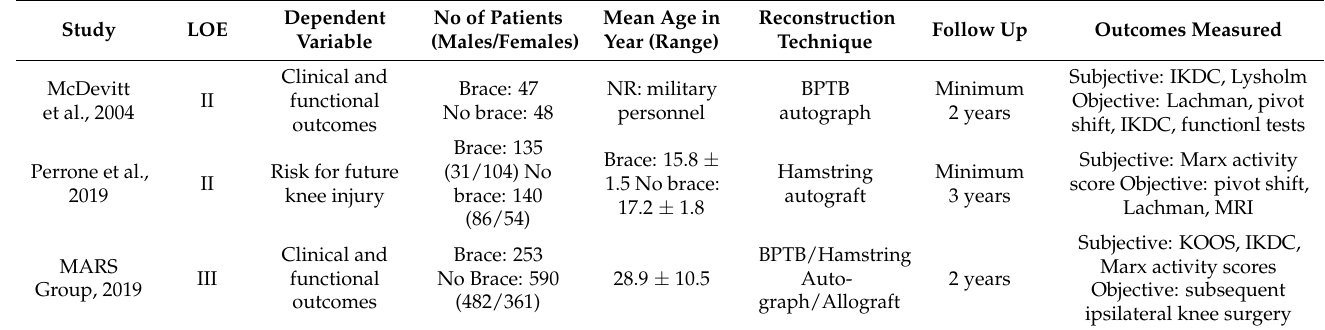
Table 5. Summary of individual study